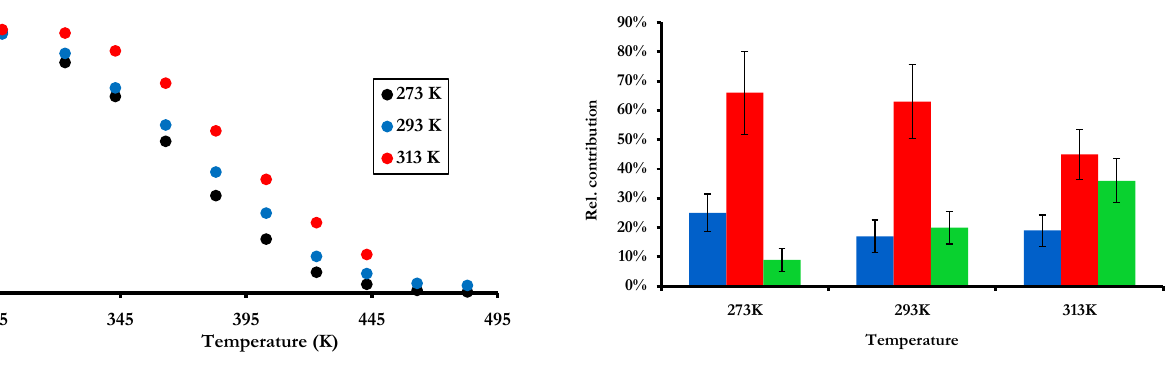
Fig. 6. The temperature dependence of VFR for α -pinene SOA from ozonolysis reactions at 273K, SOA08-3, 293K, SOA08-1 and 313K, SOA08-6 in the AIDA chamber before OH induced ageing.